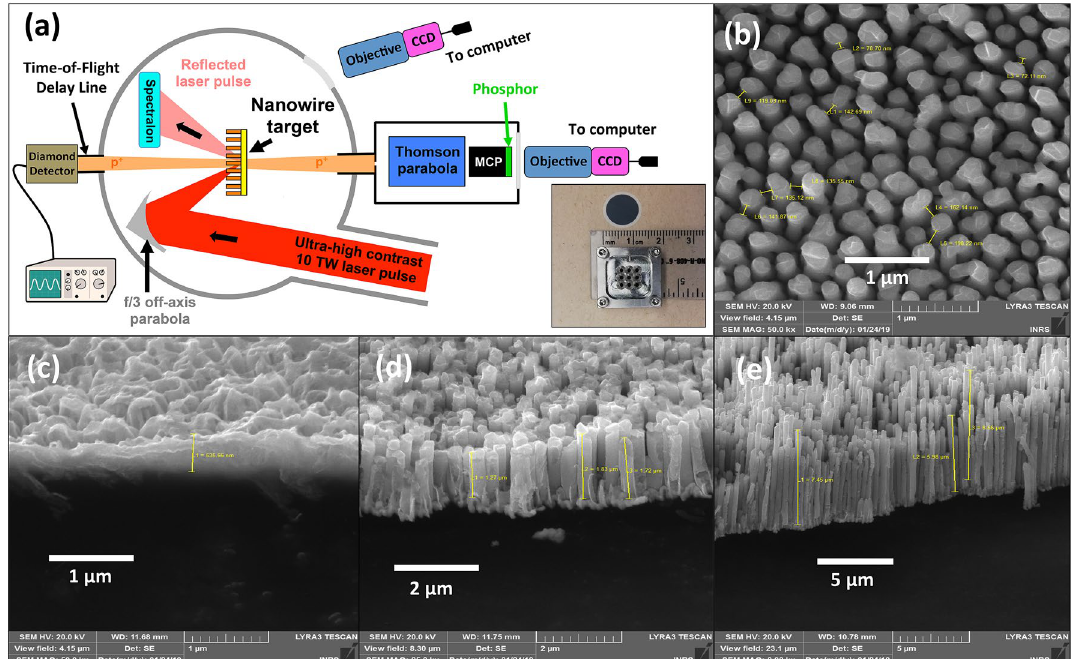
Figure 2. Experimental setup. ( a ) Schematic of the experimental setup showing the three main proton monitoring systems: a TP spectrometer at 0 ◦ , a TOF line at 180 ◦ and a Spectralon diffuser. (inset) Target holder specifically designed for holding the NW discs. ( b – e ) SEM images showing ( b ), a top view of the nanowire target. ( c – e ) different NW targets of different lengths (0.3 µ m in ( c ), 1.5 µ m in ( d ) and 8 µ m in ( e